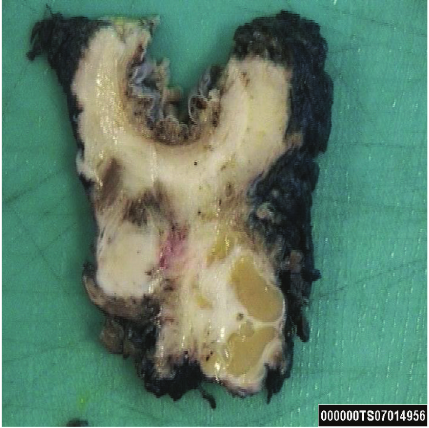
Figure1:Macroscopicappearanceoftumourwithinthetailgutcyst.